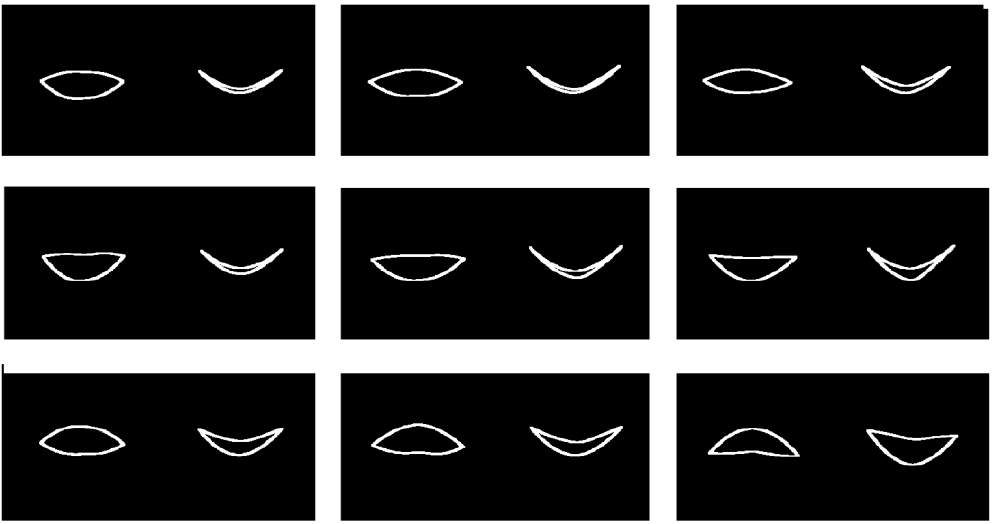
Figure 11. Visualization of the first mode of variation via mPCA at level 2 in the frontal/coronal plane (left) and horizontal plane (right) in each image. ( Left Column ) start of the smile; ( Middle Column ) mid-point (apex or plateau) of the smile; ( Right Column ) end of the smile. ( Top row ) mean shape trajectory; ( Middle Row ) mean shape trajectory minus 1 (cid:113) × first mode of variation via mPCA at level 2; ( Bottom Row ) mean shape trajectory plus 1